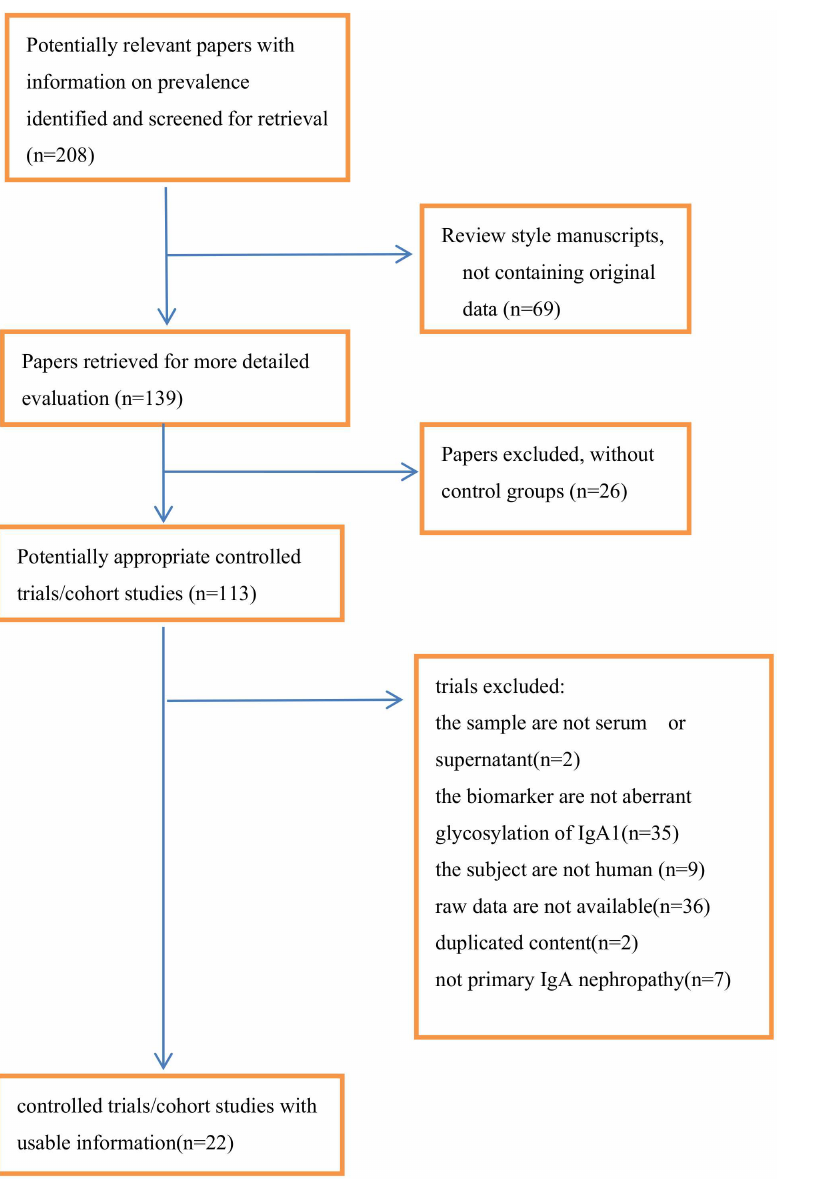
Fig 1. Flow chart of the